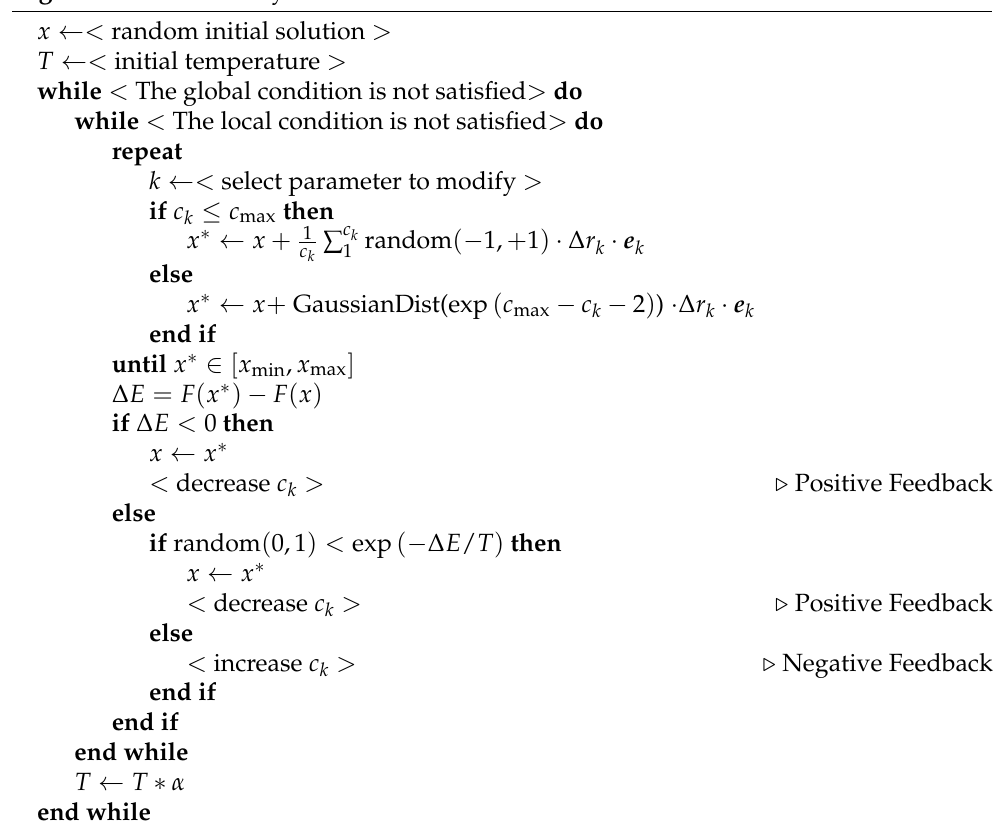
Algorithm 2 SA with crystallization heuristic.